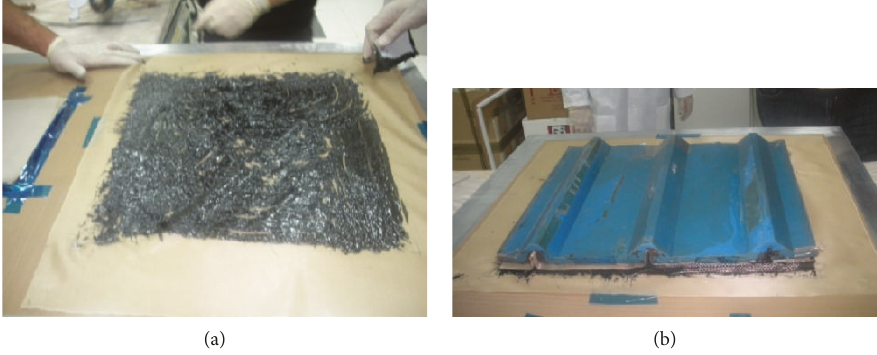
Figure 12: (a) Film of resin and (b) placing of the rubber